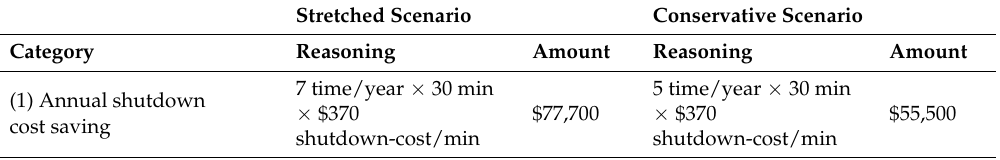
Table 2. Direct shutdown cost estimation (unit $: USD).